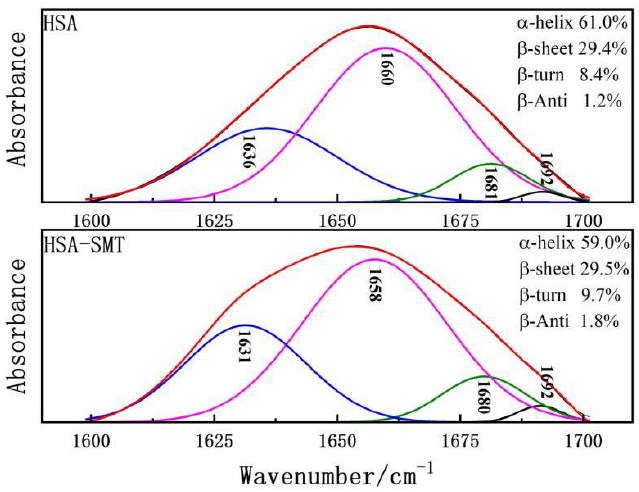
Molecules 2022 , 26 , x FOR PEER REVIEW Figure 5. Curve-fit for HSA and HSA–SMT in the amide Ι region from 1700–1600 cm −1 . Figure 5. Curve-fit for HSA and HSA–SMT in the amide I region from 1700–1600 cm